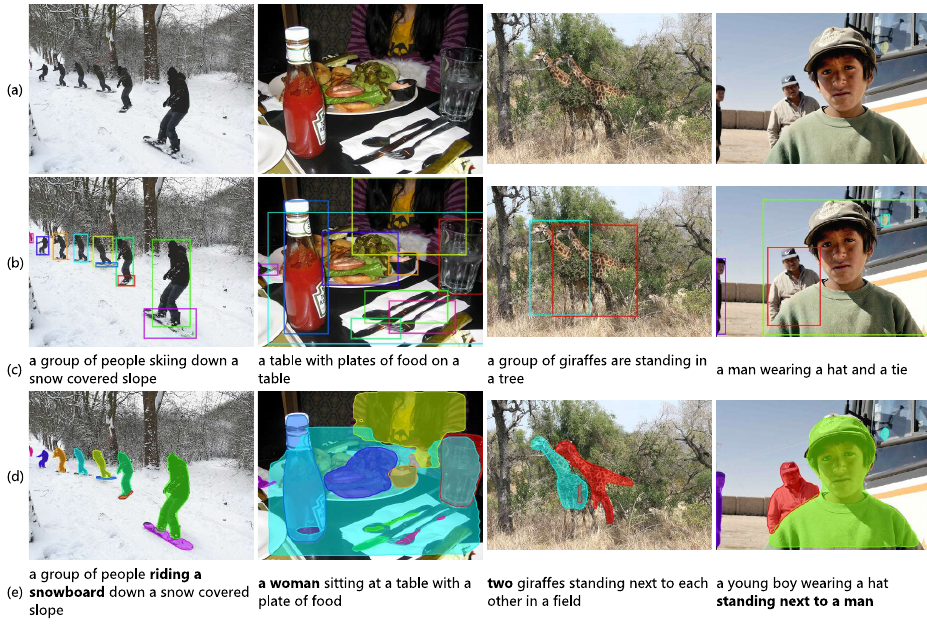
Figure 7. Examples of captions generated and the attention regions of DetectionAtt and